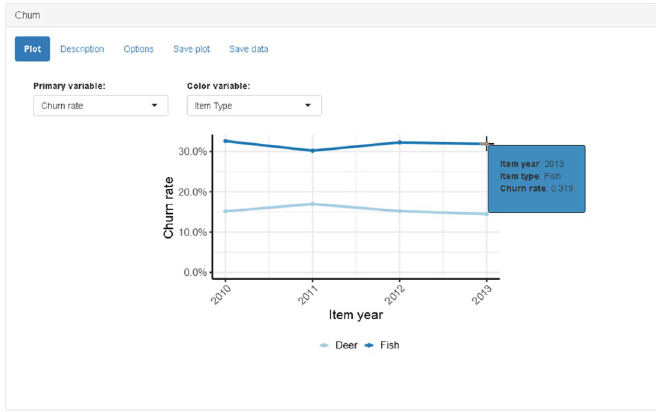
Fig 7. Screenshot of churn panel when “item type” is selected as color